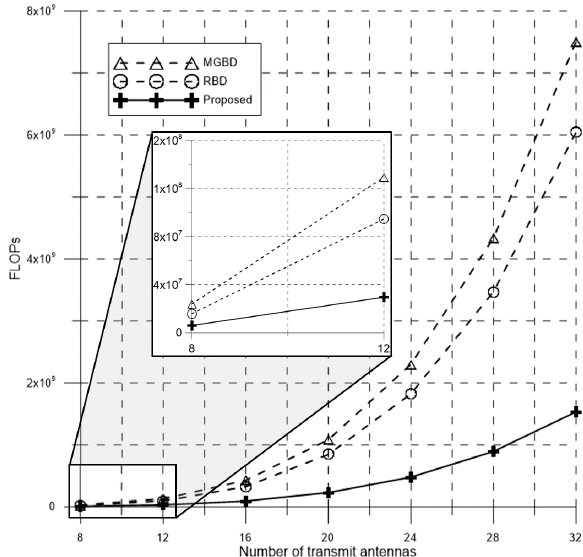
Figure 3. Computational complexity comparison at transmitter between the conventional schemes and the proposed scheme in